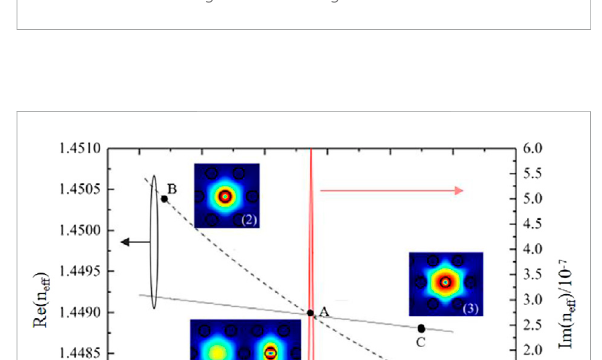
FIGURE 7 Resonance wavelength versus voltage.